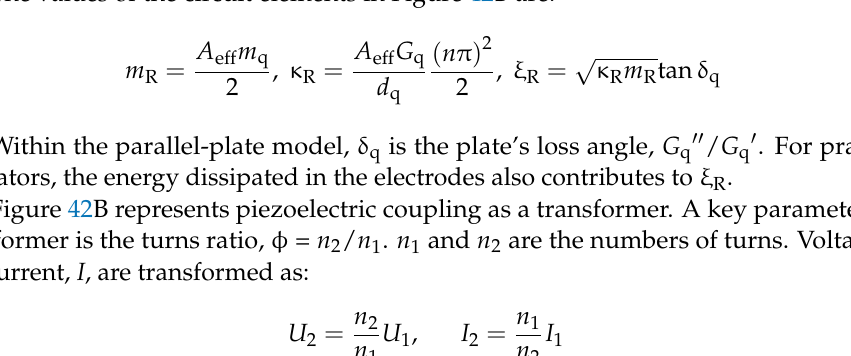
Figure 43. Electrical engineers sometimes draw mechanical equivalent circuits, such that the elec- Kirchhoff rules apply [52]. This is not the convention followed in Figure trical Kirchhoff rules apply [52]. This is not the convention followed in Figure 42.